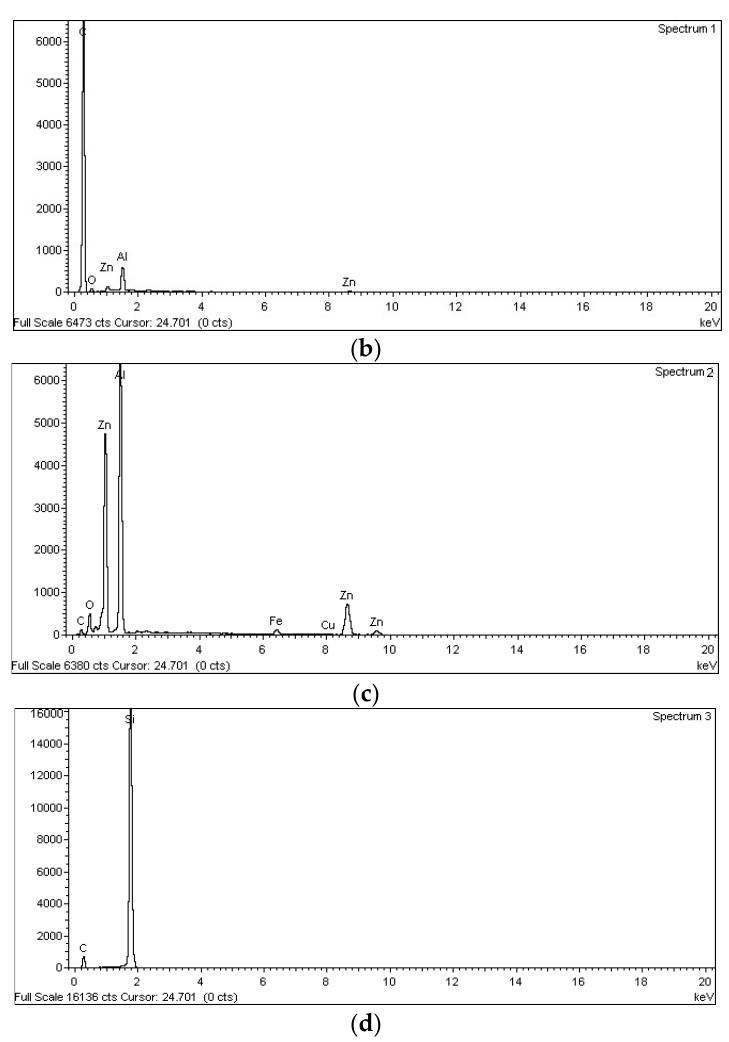
Figure 10. SEM micrograph and energy dispersive spectrometry (EDS) analyses of the worn surface of ZA27/5% SiC/5%Gr for 120 N of normal load and 0.25 m/s of sliding speed: ( a ) SEM micrograph; ( b ) Spectrum 1; ( c ) Spectrum 2; ( d ) Spectrum 3.